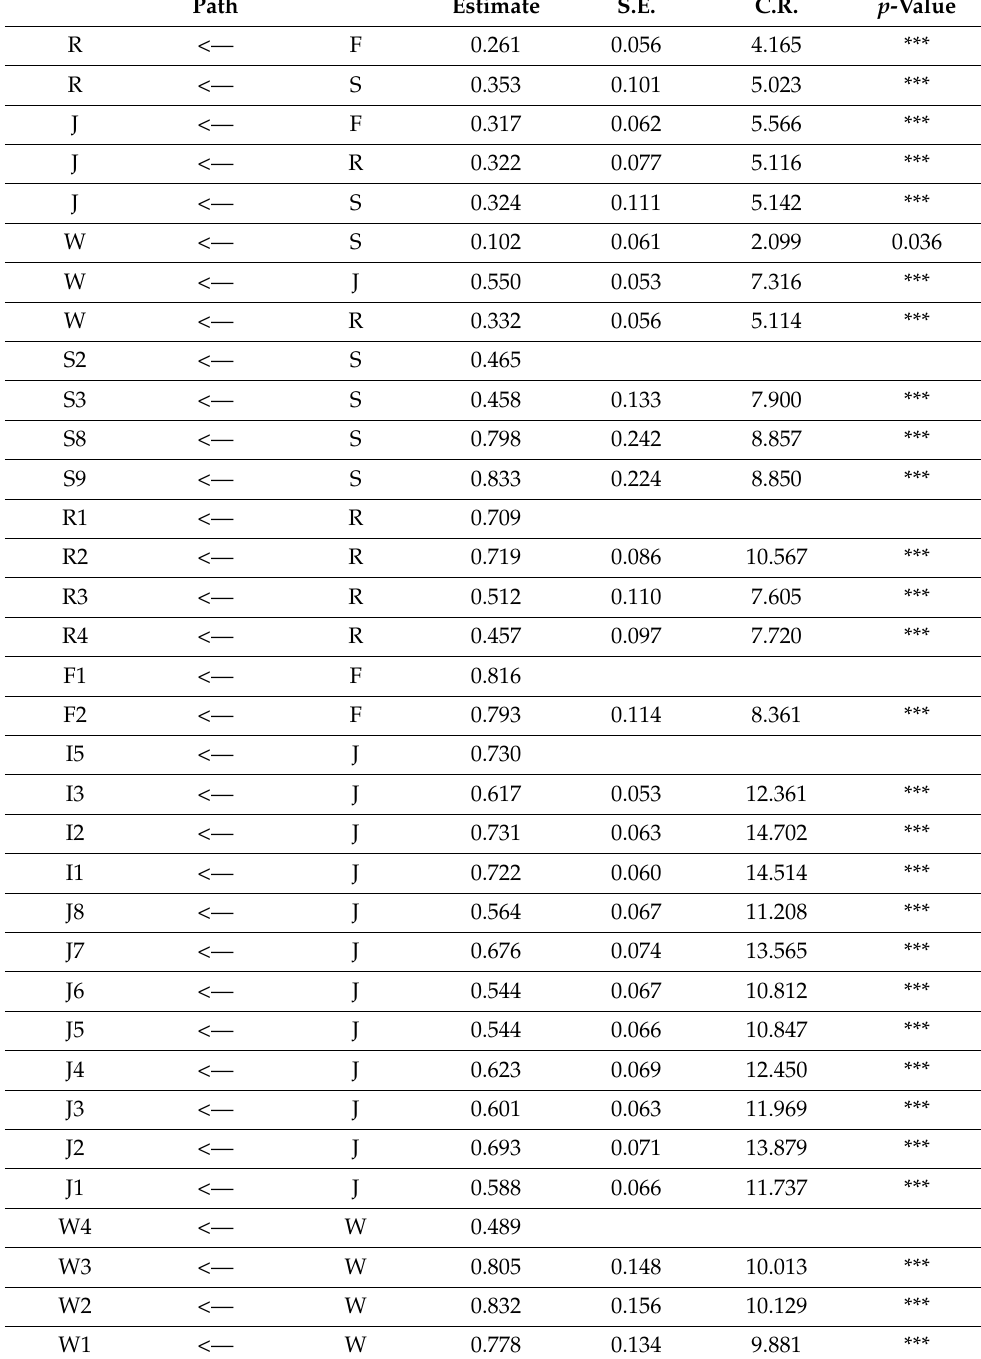
Table 13. Normalized Path Coefficients of Modified